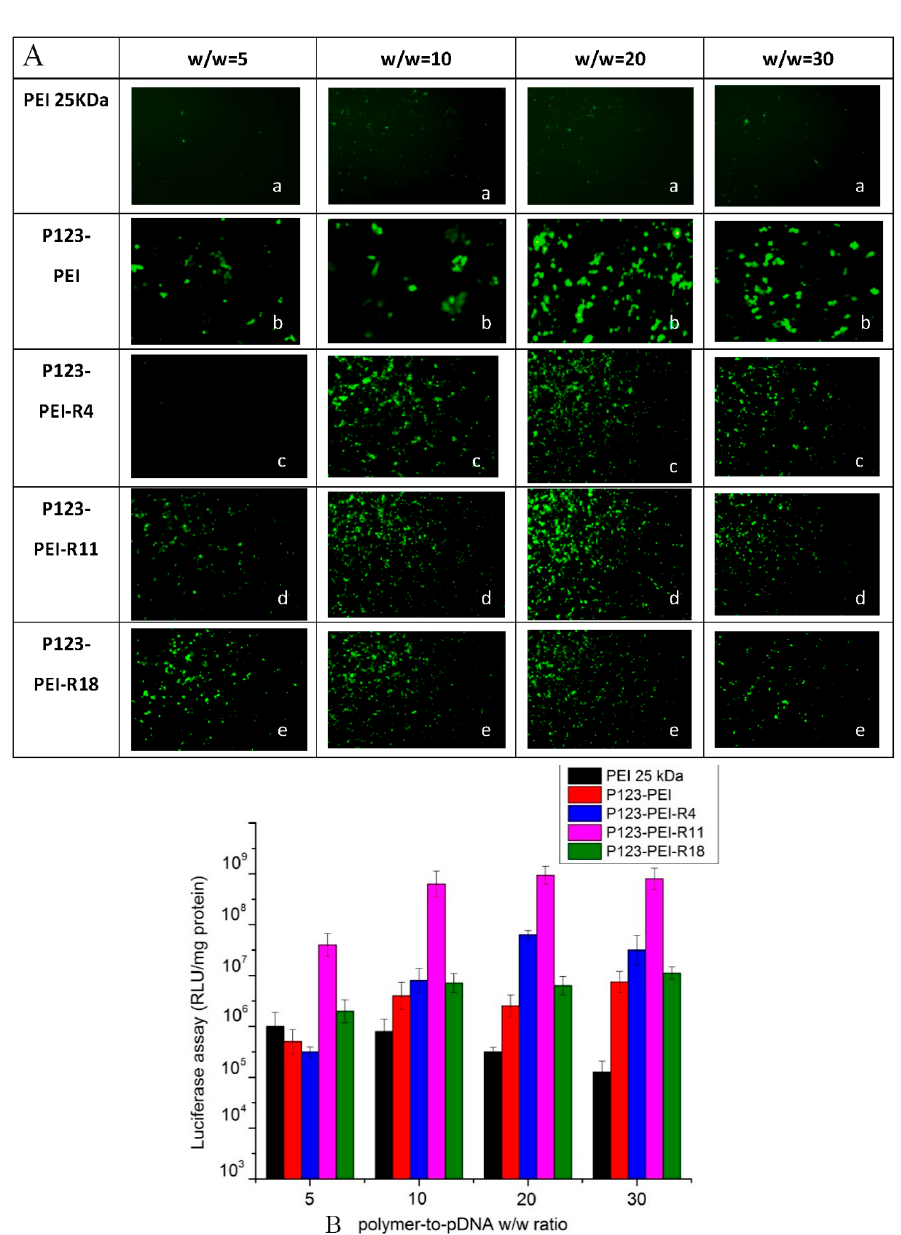
individual peptide. In the Figure 7B showed that transfection efficiency of P123-PEI-R11 was the highest, indicating that RGD-NLS is the most effective of the four peptide-modified P123-PEI.